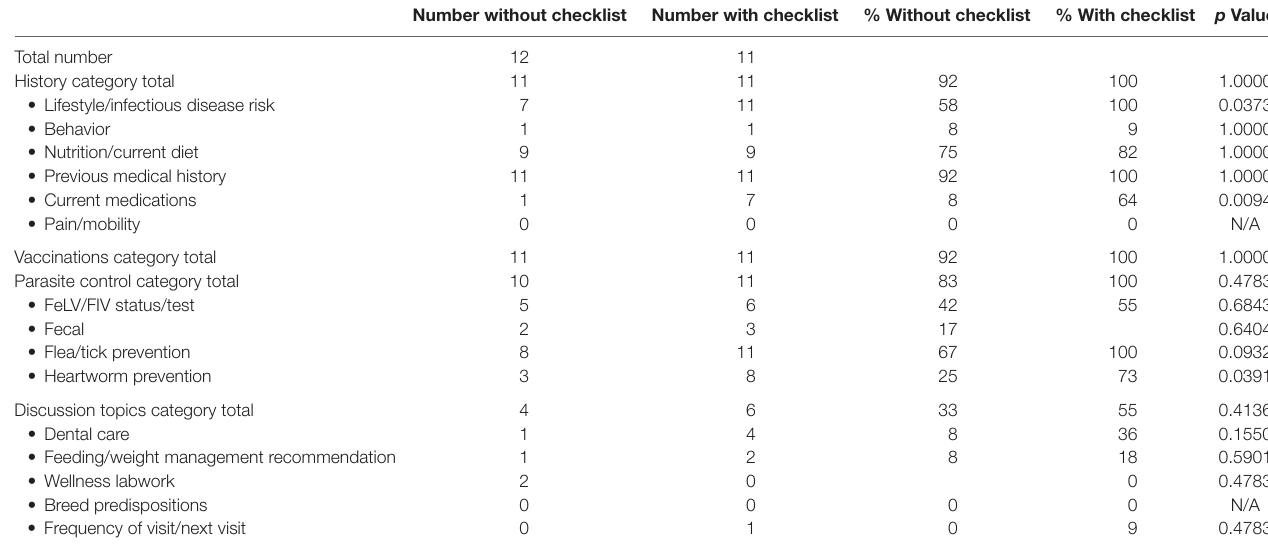
TaBle 2 | Feline visit totals, percentages, and p